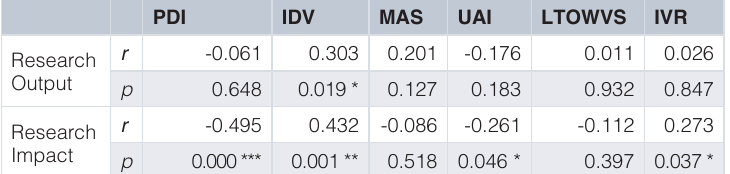
Table 4. Partial correlations between national cultures dimensions and research output and impact, controlling Log GDP per capita (LGDP) ( N = 60, df =